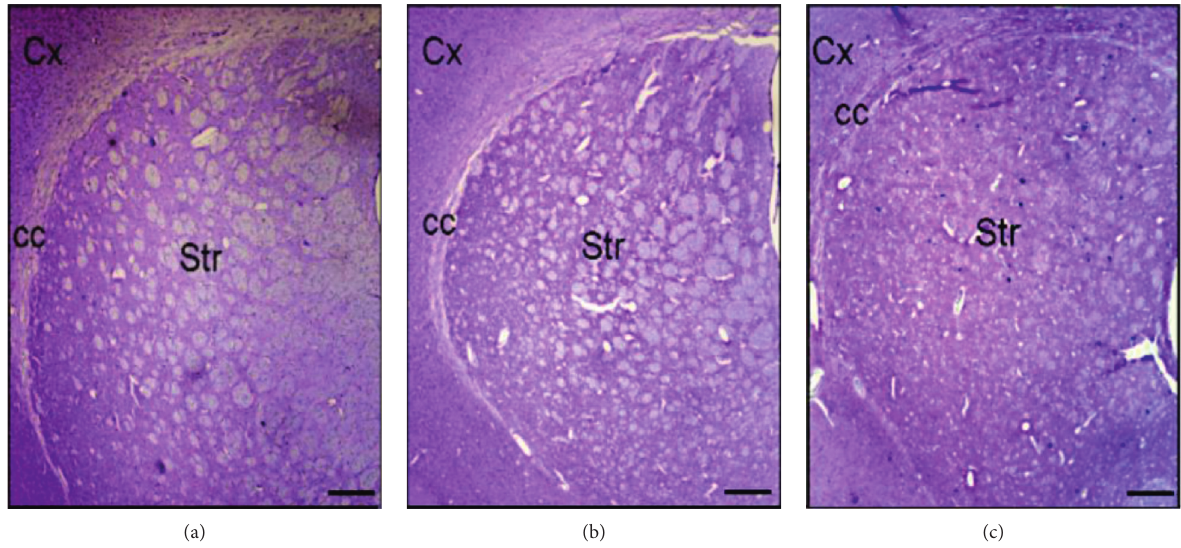
Figure 6: (a) Control group (6-OHDA-induced lesion rats); (b) CAPE 20 group; (c) CAPE 80 group. cc: corpus callusum, Cx: cortex, Str: striatum. Magnification × 400. Internal scale bar � 500 μ